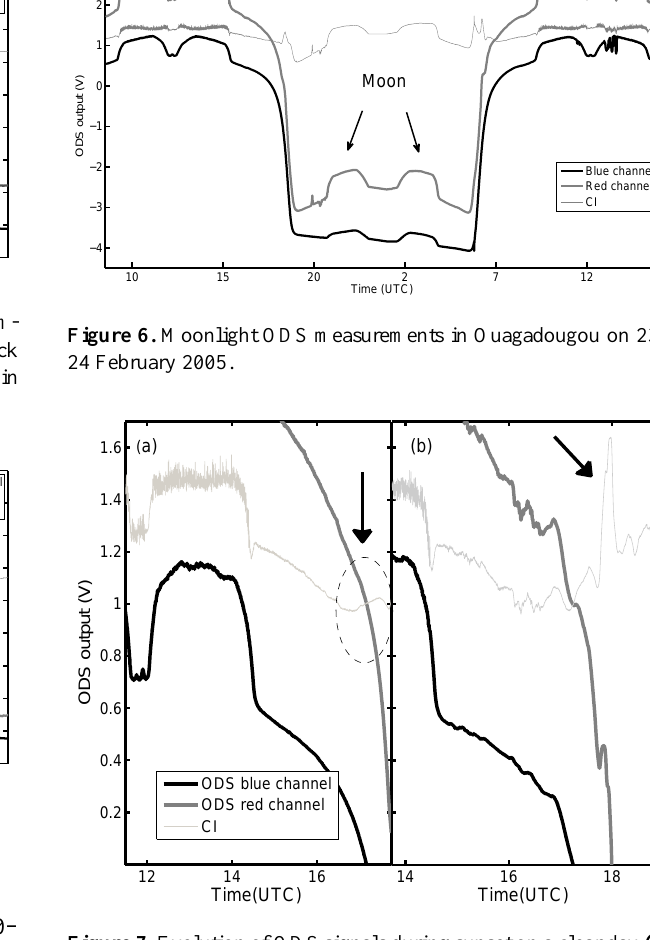
Figure 7. Evolution of ODS signals during sunset on a clear day (a) and slightly cloudy day (b)